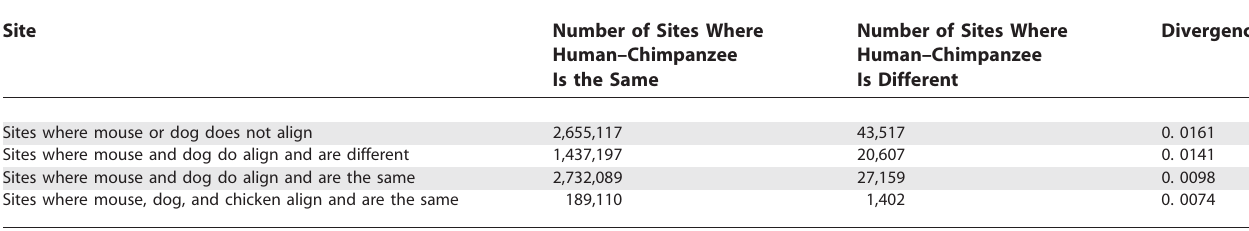
Table 1. Human–Chimpanzee Divergence Relative to Mouse, Dog, and Chicken Alignments